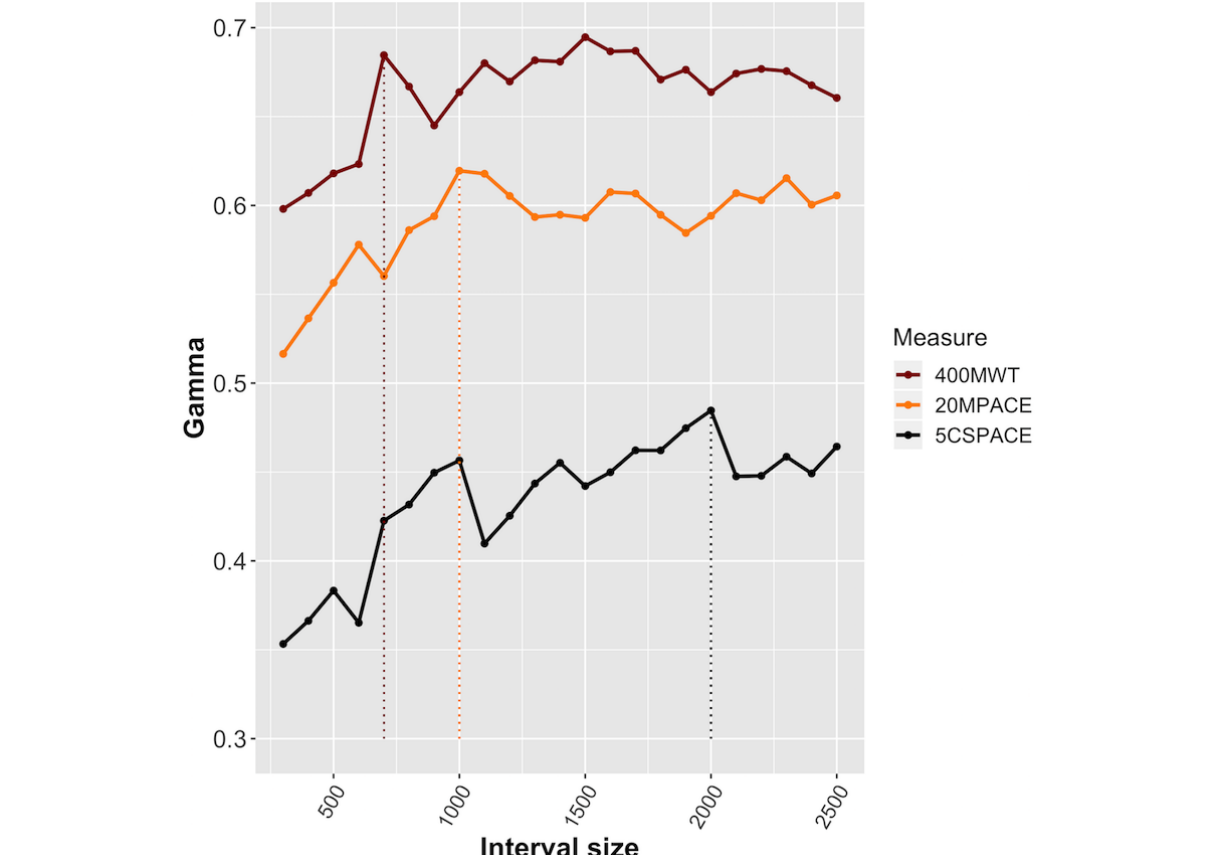
Figure 5. The mean Gamma (Goodman-Kruskal rank correlation between the predicted and true responses) in 5-fold cross-validation for 20MPACE (20-m walk test), 5CSPACE (number of sit-to-stands per second measured over 5 repetitions), and 400MWT (400-m walk test)